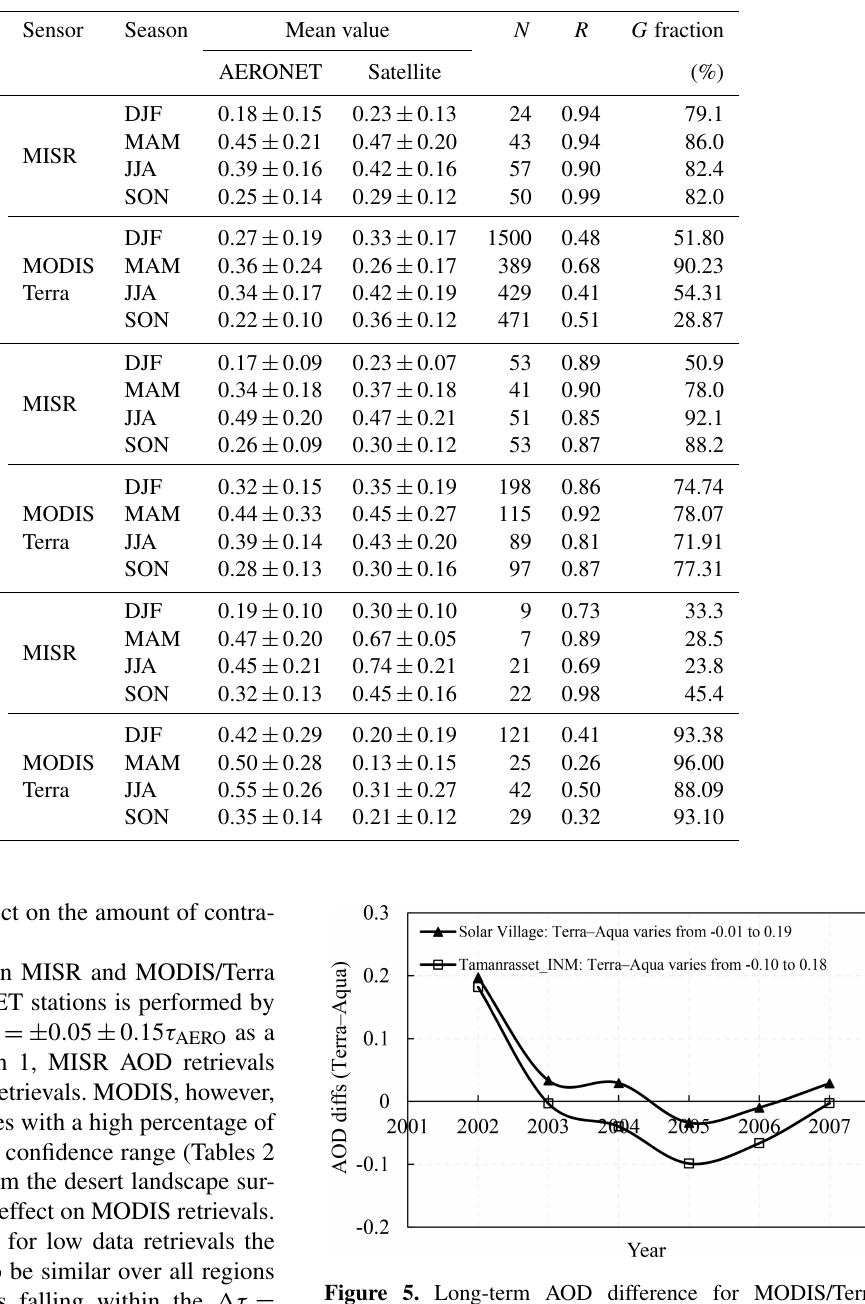
Table 2. Statistics for dust sites. R : correlation coefficient; RMSD: root mean square deviation; G fraction: good fraction; N : number of observations